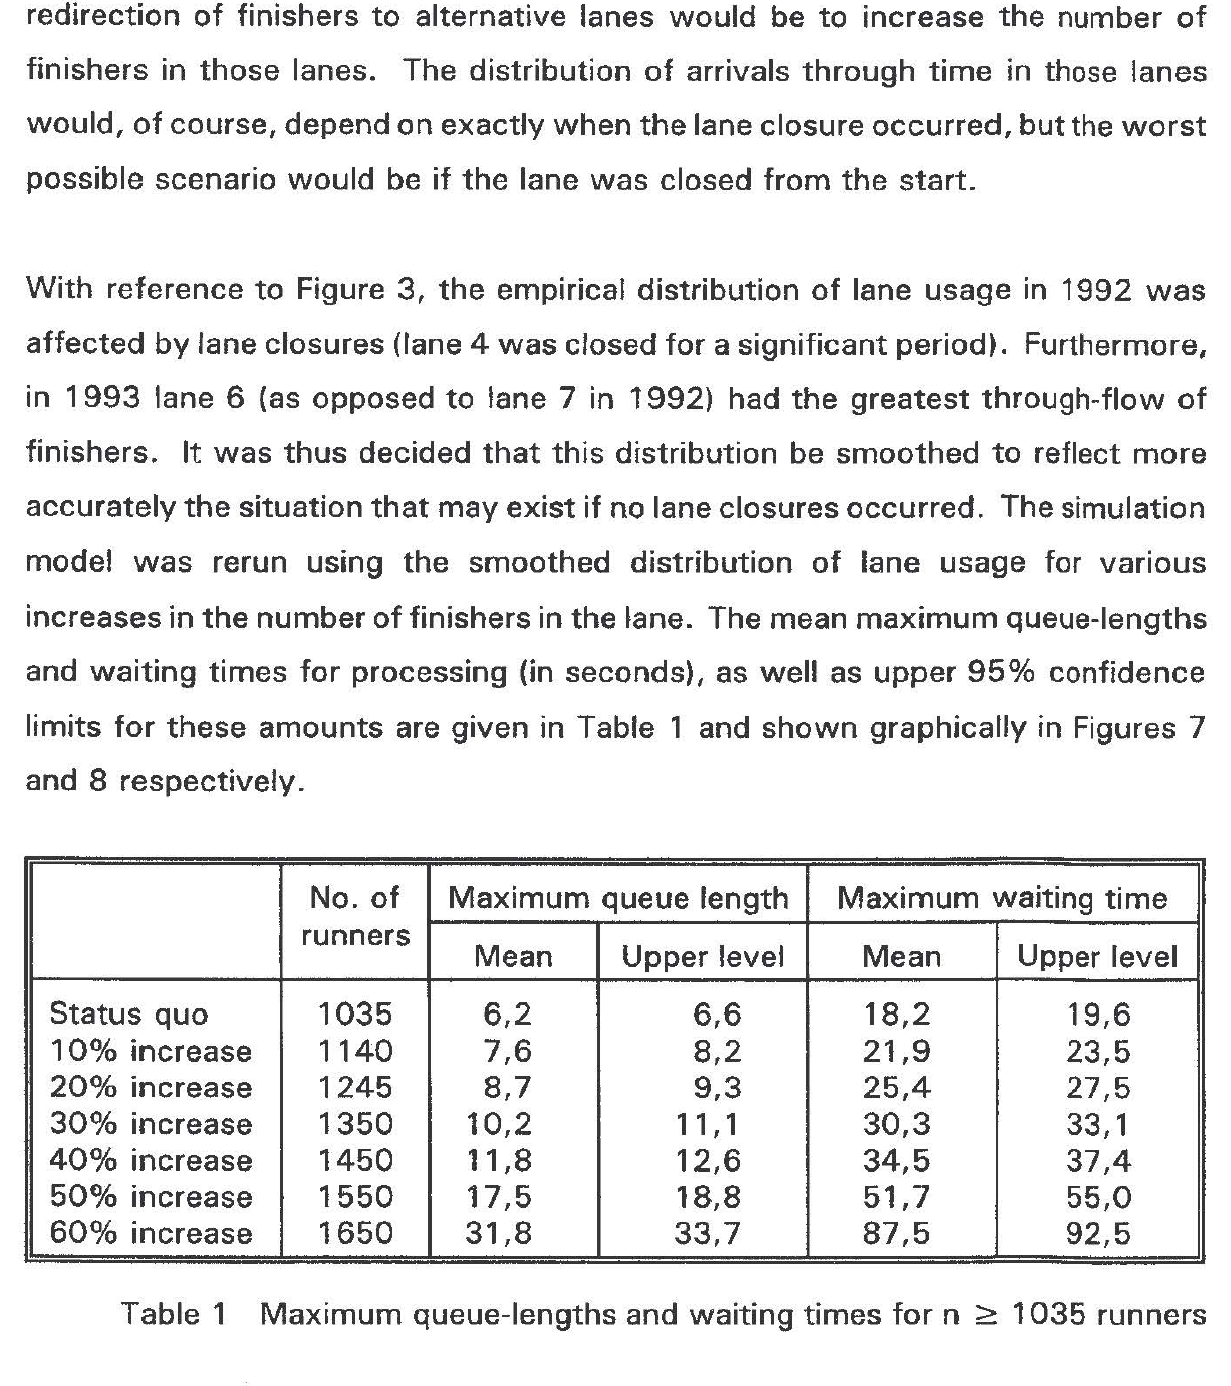
Maximum queue-lengths and waiting times for n > 1035